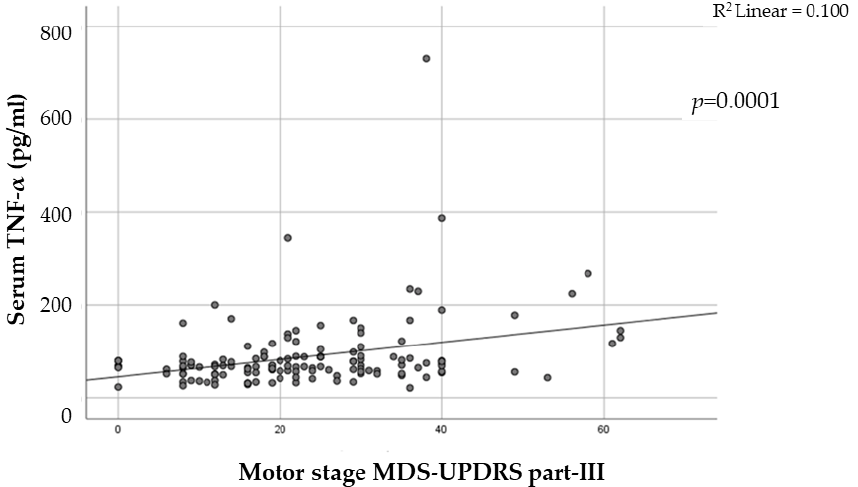
Figure 2. Linear multiple regression analysis showing the association between serum levels of TNF-a and disease severity measured by MDS-UPDRS part III. The higher the score in UPDRS part III, the higher the levels of serum TNF-a ( p ≤ 0.0001).